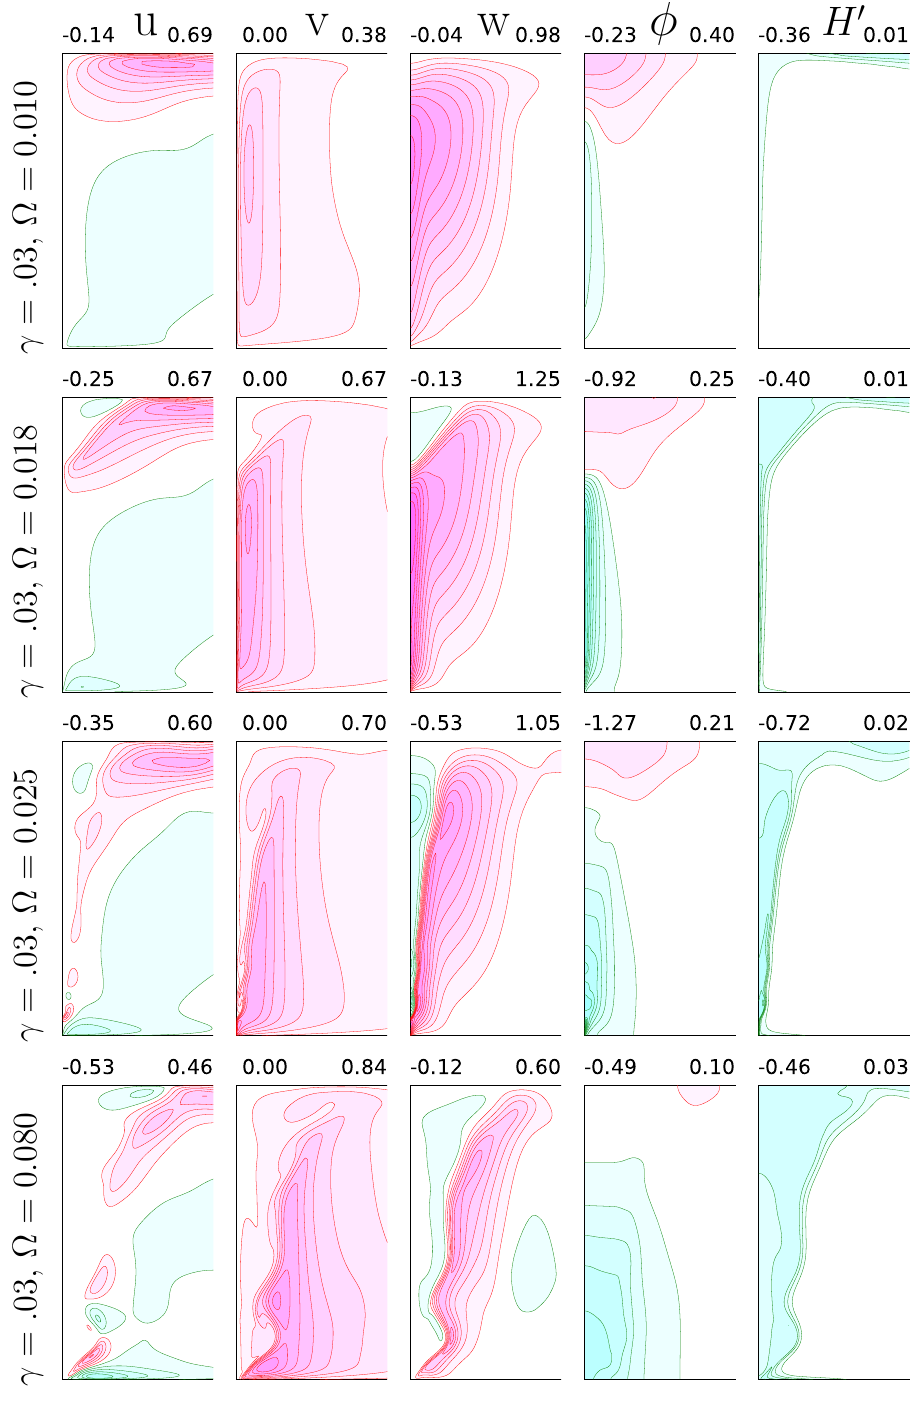
Figure 3. Simulations with γ = 0.03 at t = 225, except for Ω = 0.025, which is at t =